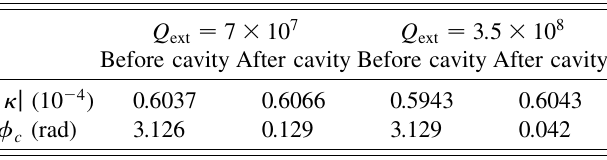
TABLE III. Coupler kick parameters with optimized coupler